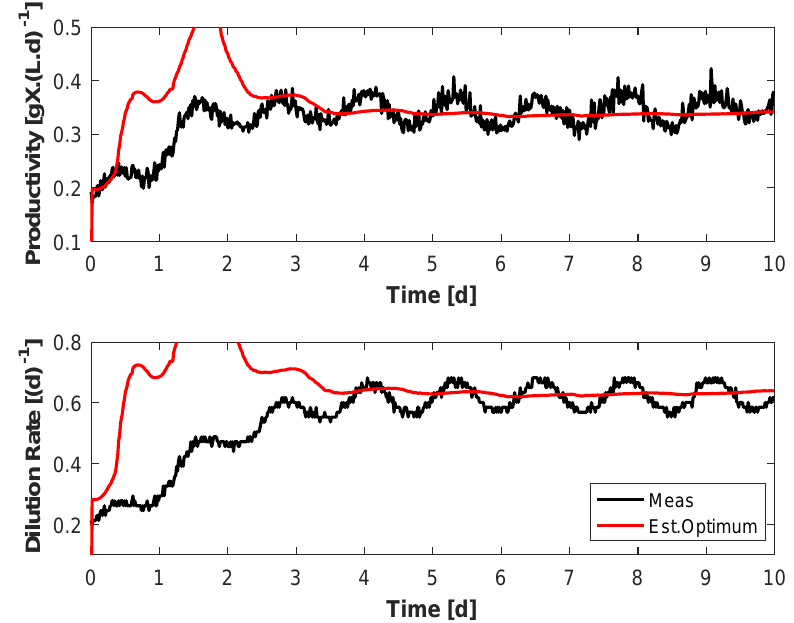
Figure 15. Experimental validation of RLS-ES on Dunaliella tertiolecta continuous cultures: productivity and dilution rate evolutions—reproduced with permission from [102].